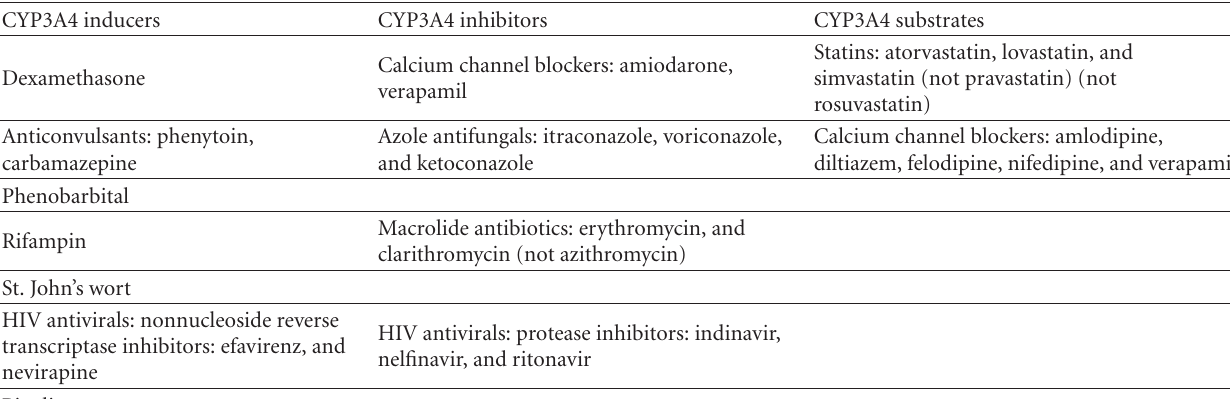
Table 2: Clinically significant CYP3A4 inducers, inhibitors, and